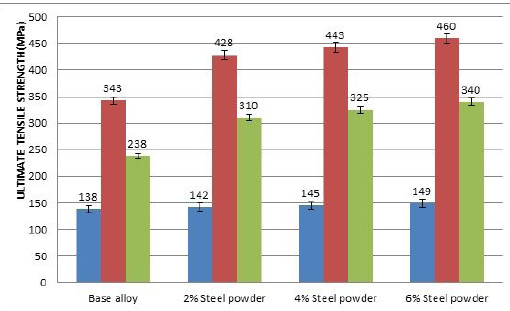
Figure 13. UTS of as cast and peak aged Al 7075 eutectoid steel reinforced composite- Martensite hybrid treatment.